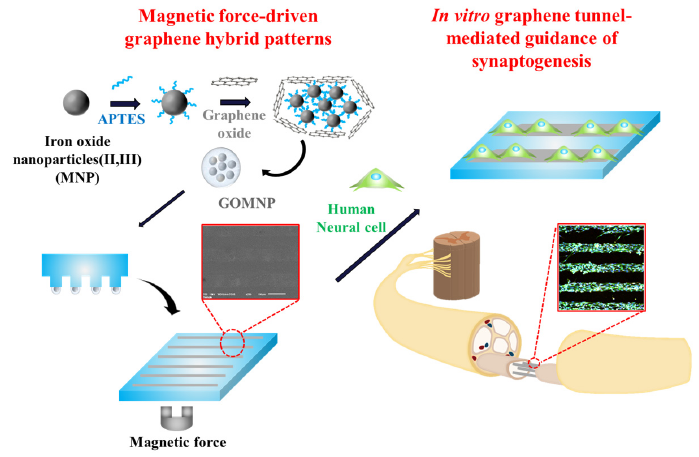
Figure 1. Schematic diagram illustrating synthesis of GO-encapsulated magnetic nanoparticles and conformation of GO hybrid pattern. By using this method, synaptogenesis guidance can be controlled.